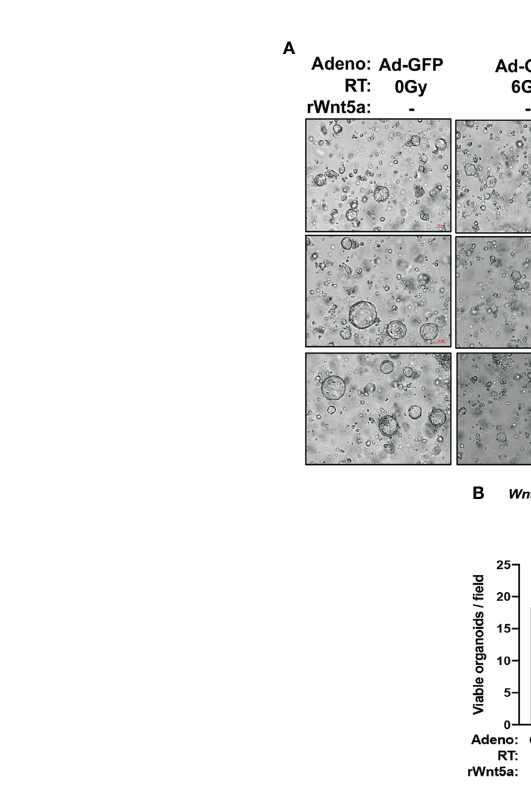
FIGURE 6 | rWnt5a treatment rescues crypt regeneration in irradiated Wnt5a CKO duodenal organoids. Wnt5a fl / fl organoids were infected with Adeno-Cre-GFP or control Adeno-GFP, treated with vehicle or rWnt5a (600 ng/ml), and then treated with the indicated doses of ionizing radiation. (A) Representative bright fi eld images with (B) quanti fi cation of viable organoids are shown 6 days after irradiation (n = 3 per group). All error bars represent mean ± SEM. * P < 0.05, ** P < 0.01, *** P < 0.001, **** P < 0.0001, and ns = not signi fi cant, by Tukey ’ s multiple comparisons test" instead of "* P < 0.05, ** P < 0.01, *** P < 0.001, **** P < 0.0001, and ns, not signi fi cant, by Tukey's multiple comparisons